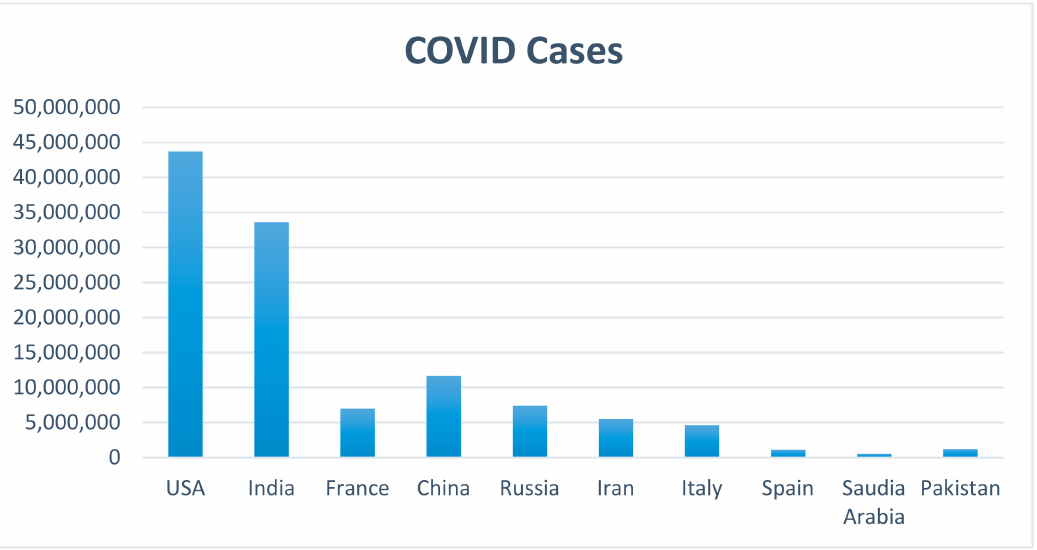
Figure 1. Worldwide corona virus case